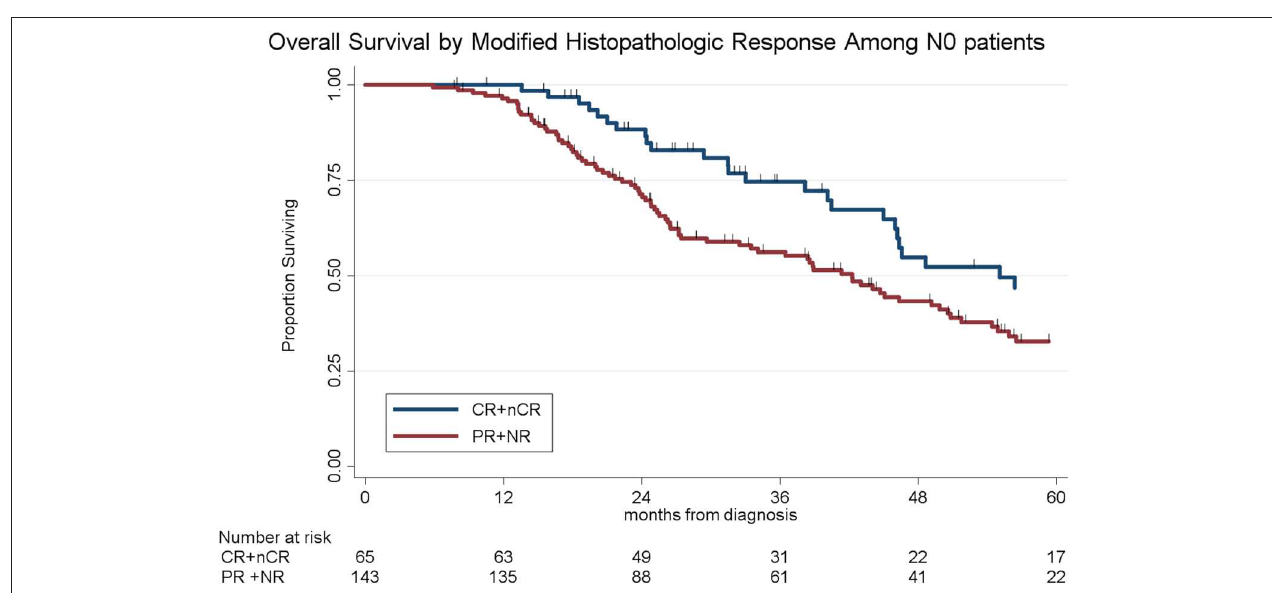
FIGURE 2 | Overall survival by modified histopathologic response of the primary